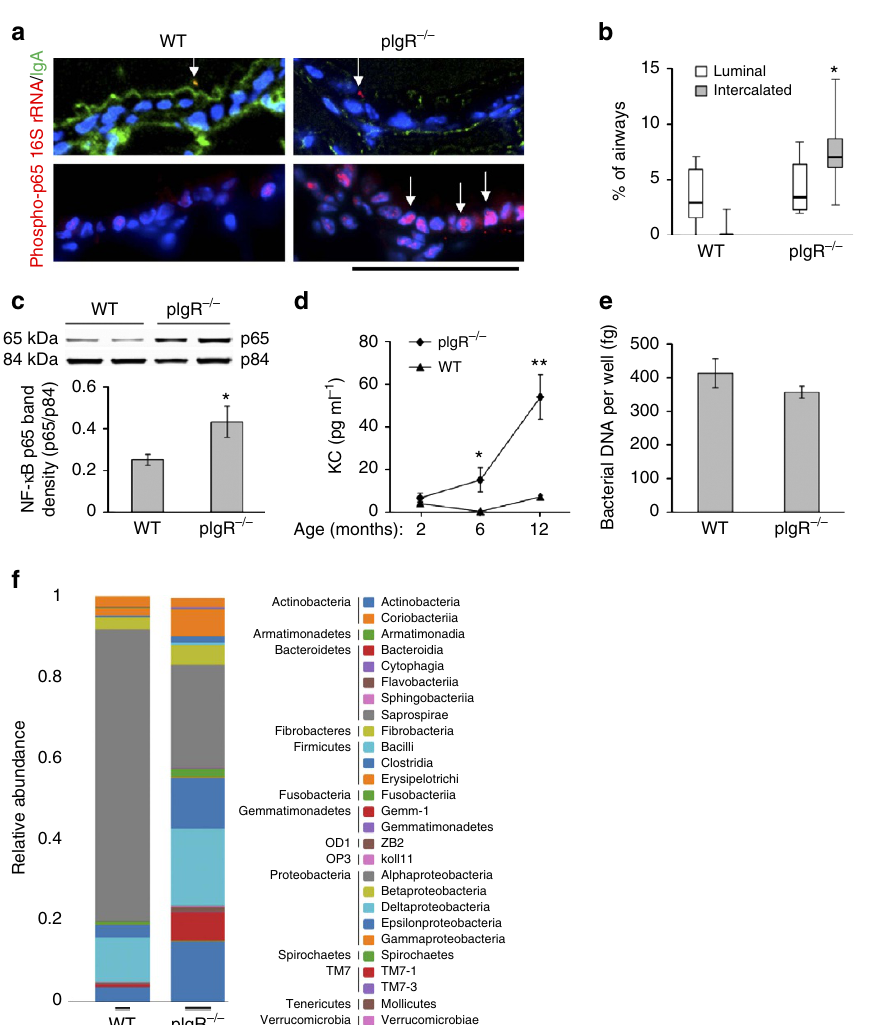
Figure 3 | Bacterial invasion and NF- j B activation in airways of pIgR (cid:2) / (cid:2) mice. ( a ) Immunofluorescent detection of bacteria (fluorescent in situ hybridization (FISH) probe for 16S rRNA, red, top panels) or NF- k B (phospho-p65 (Ser276, red, bottom panels), IgA (green, top panels) and DAPI (blue) from 12-month-old WT and pIgR (cid:2) / (cid:2) mice (original magnification, (cid:3) 1,000). In WT mice, bacteria with bound SIgA were identified within the airway lumen (yellow on merged image, identified by arrow), whereas bacteria intercalated within the epithelium were identified in pIgR (cid:2) / (cid:2) mice (red, identified by arrow). Bottom panels show phopsho-p65 localized to nuclei (arrows). Scale bar, 50 m m. ( b ) Box and whisker plot (showing median, 25th–75th percentile and range) for intraepithelial (intercalated) and luminal bacteria in airways of 12-month-old WT and pIgR (cid:2) / (cid:2) mice as identified by FISH for bacterial DNA. Seven mice per group; * P o 0.001. ( c ) Western blotting and densitometry for p65 component of NF- k B (normalized to p84) in nuclear protein extracts from lungs of 12-month-old WTand pIgR (cid:2) / (cid:2) mice. Six mice per group; * P o 0.05 (Student’s t -test). ( d ) KC protein levels in BAL fluid. Six mice per group; * P o 0.05 compared with 2-month-old pIgR (cid:2) / (cid:2) mice and age-matched WTcontrols; ** P o 0.05 compared with all other groups (two-way analysis of variance (ANOVA)). ( e ) Total bacterial DNA was quantified from lung tissue in WT and pIgR (cid:2) / (cid:2) mice using quantitative PCR (qPCR) and primers specific for V1 region of prokaryotic 16S rRNA. Ten mice per group. ( f ) Distribution of bacterial phyla and classes in lung tissue as determined by 16S sequencing from lungs of 12-month-old WT and pIgR (cid:2) / (cid:2) mice (three mice studied per group but only two WT mice had sufficient bacterial DNA amplification for detailed reduced to levels similar to that of WT mice (with standard or (C57BL/6 background) were generated at the National sterile housing) (Fig. 5f,g). To investigate the impact of Gnotobiotic Rodent Resource Center and maintained in sterile conditions. In contrast to pIgR (cid:2) / (cid:2) mice maintained in standard housing, 6-month-old germ-free pIgR (cid:2) / (cid:2) mice were completely (Fig. 5a–e). Although the COPD-like remodelling progressed from 6 to 12 months of age in pIgR (cid:2) / (cid:2) mice housed in standard conditions, no evidence of small airway remodelling or emphysema was observed in germ-free pIgR (cid:2) / (cid:2) mice, even at 12 months of age. Neutrophils were essentially undetectable in the alveolar parenchyma from germ-free pIgR (cid:2) / (cid:2) and WT mice, and macrophage counts in germ-free pIgR (cid:2) / (cid:2) mice were